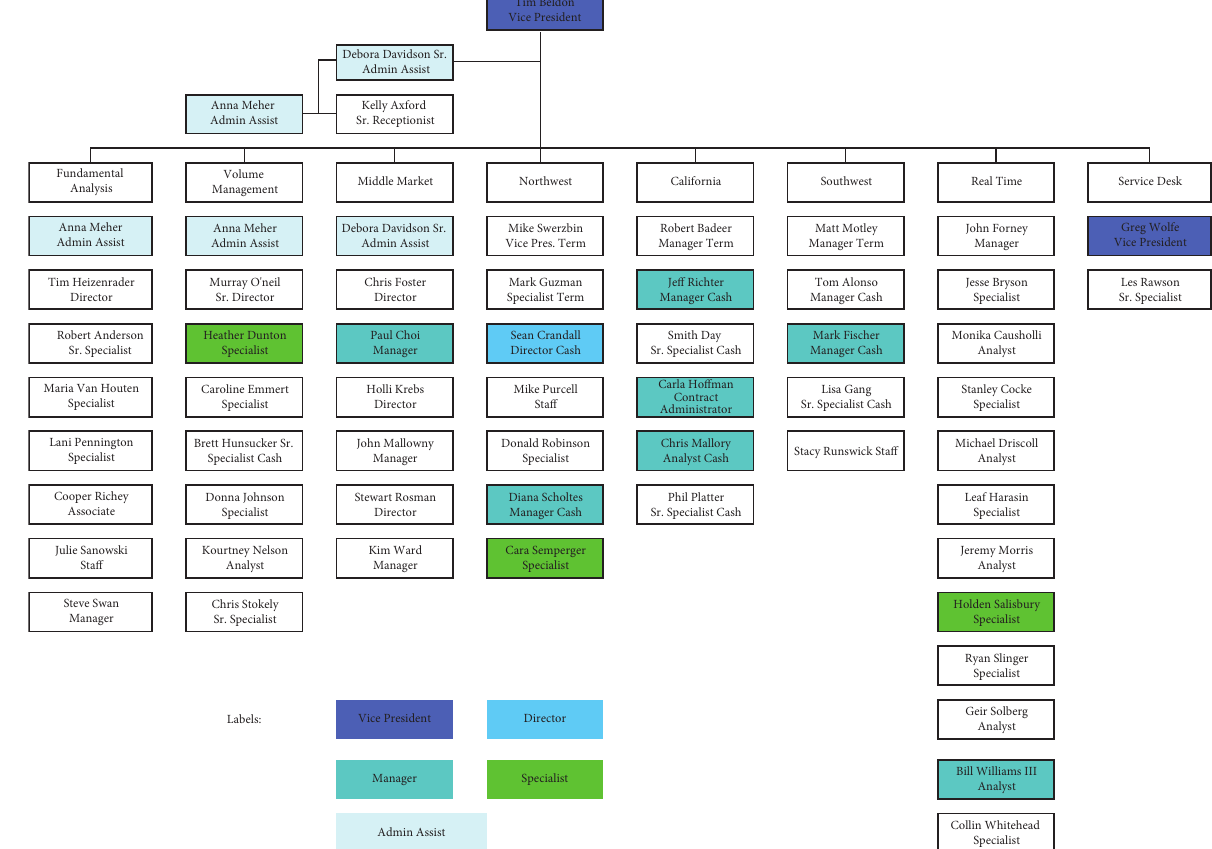
Figure 3: Network chart with highlighted results. Graph highlights the fifteen employees (about a third) with the highest CorpRank